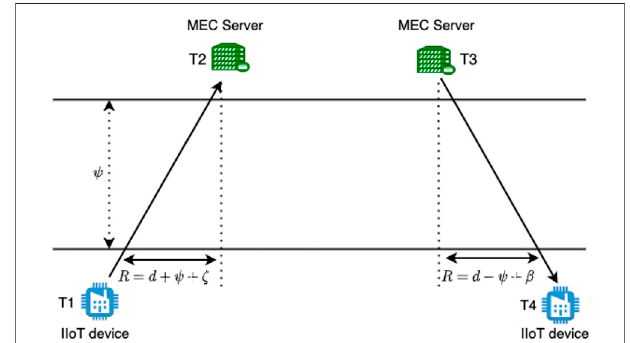
FIGURE 3 | ATS time Synchronization